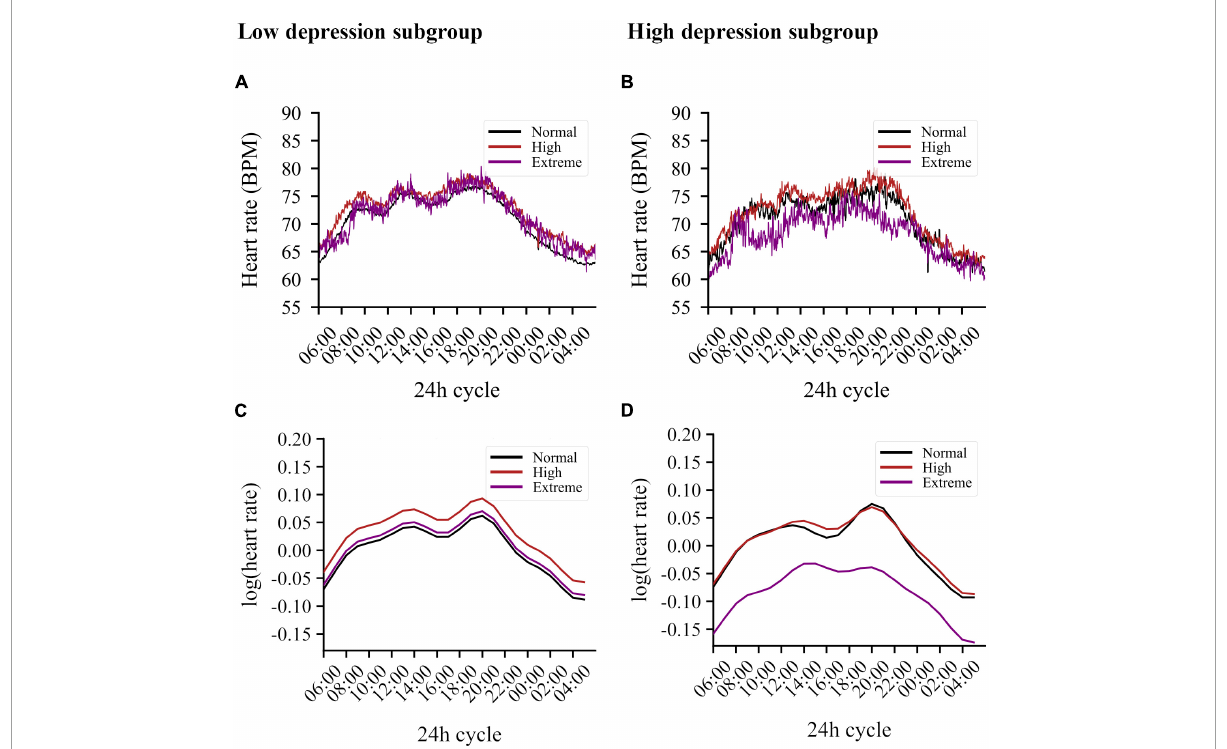
FIGURE1 Circadian variations in heart rate averaged per stress subgroup for both low and high depression scores. (A) Averaging results for the low depression subgroup. Chronic stress levels are indicated by color: normative levels in black, high levels in red, extreme levels in purple. (B) Averaging results for the low depression subgroup. (C) Simulation results derived from the model for the low depression subgroup. The graph illustrates the log-transformed HR derived from this model using only the harmonic and stress-related terms, therefore, without the influence of BMI, sex, activity, and smoking behavior. Participants with high levels of chronic stress show the highest increase in HR. (D) Simulation results derived from the model for the high depression subgroup. Whereas the negative main effect of the 12 h-based sine wave causes an increase in the morning and evening, the positive interaction of this wave with extreme stress counteracts this, resulting in a diminished evening peak and an elevated plateau in the afternoon. Similarly, the positive interaction including the 8 h-based cosine wave counteracts the negative main effect of this wave, resulting in, among other effects, an additional reduction of the evening peak in participants with extreme